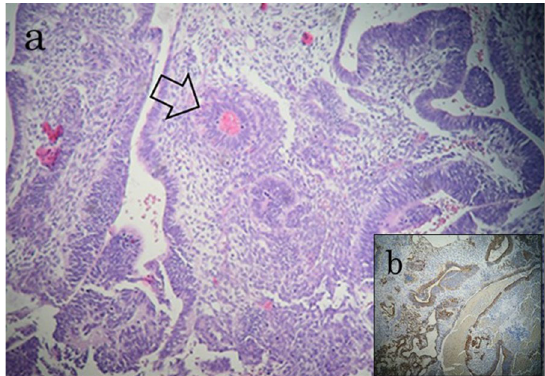
Fig. 4 a Histological section showing immature teratoma composed of undifferentiated cells with foci of primitive neuroectodermic differentiation forming immature neuroepithelial tissue (arrow), in a cellular stroma (hematoxylin and eosin, 20 magnification). b × Immunochemical results demonstrated positivity for S 100 protein and glial fibrillary acidic protein markers, compatible with primitive neuroectodermal tissue (metastases of the teratoma component of the primary mixed GCT), (20 magnification) ×